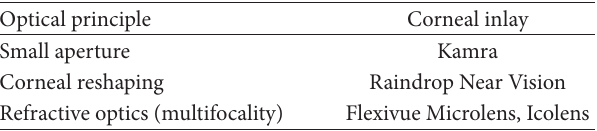
Table 1: Optical principles of corneal